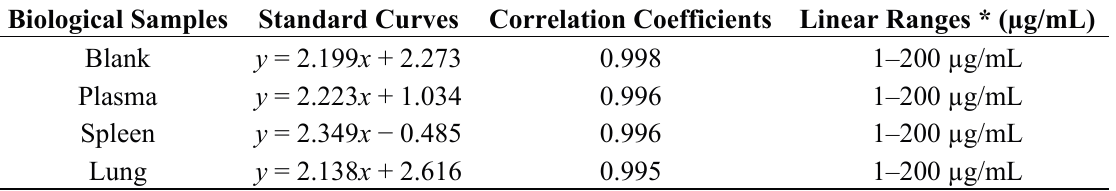
Table 1. Calibration curves for Fluorescein isothiocyanate-labeled longan polysaccharide-protein complexes (LPPF) in mouse plasma and tissue homogenate supernatants. Biological Samples Standard Curves Correlation Coefficients Linear Ranges * (µg/mL) Blank Spleen Lung * Data were obtained at six concentrations, and each repeated in triplicate.